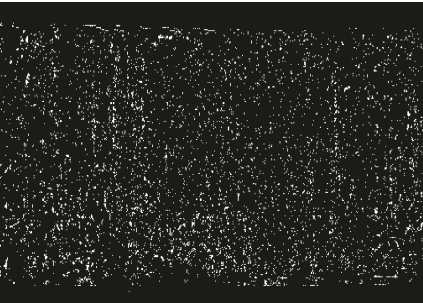
Figure 4: Final image of the noncube texture.